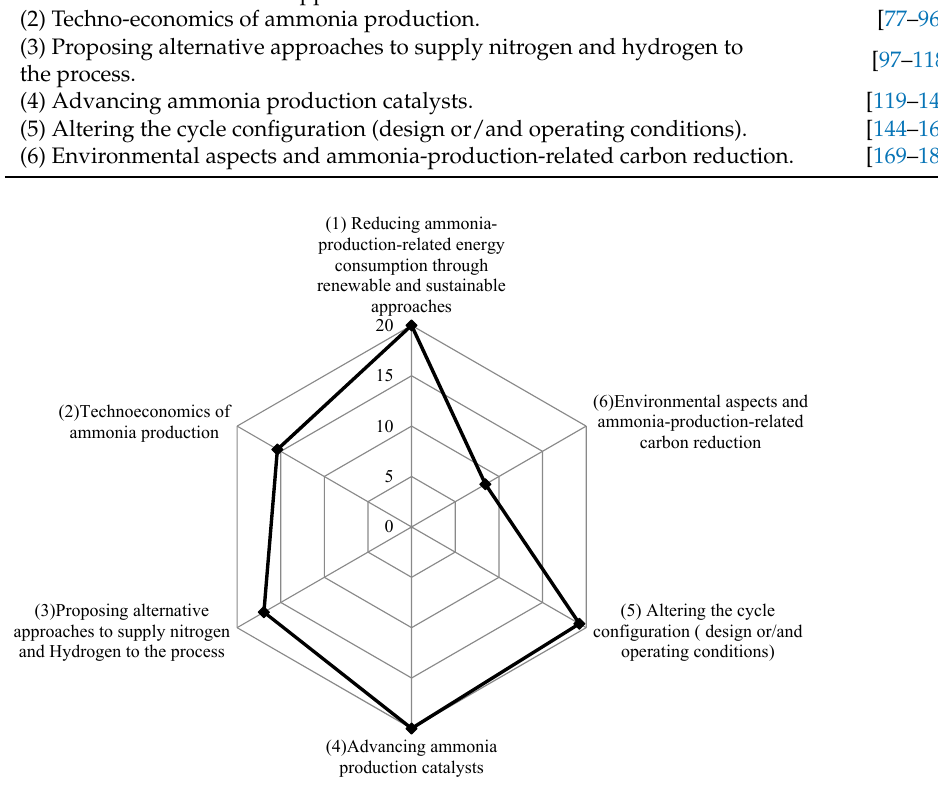
Figure 12. The scientific trend of advancing ammonia plants (in% with respect to the total number of the evaluated literature [51–180]).